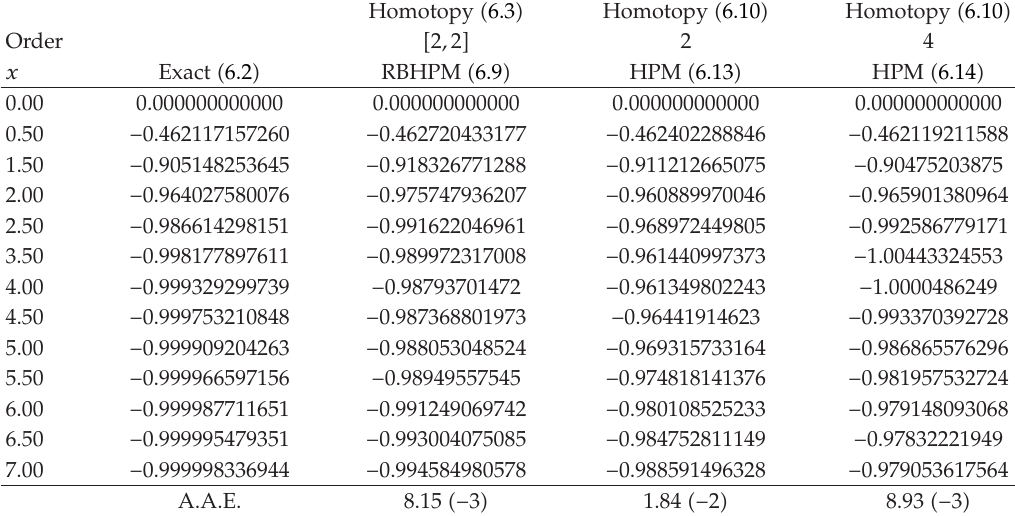
Table 1: Comparison between exact solution (cid:3) 6.2 (cid:4) for (cid:3) 6.1 (cid:4) to the results of approximations (cid:3) 6.9 (cid:4) , (cid:3) 6.13 (cid:4) , and (cid:3) 6.14 (cid:4)